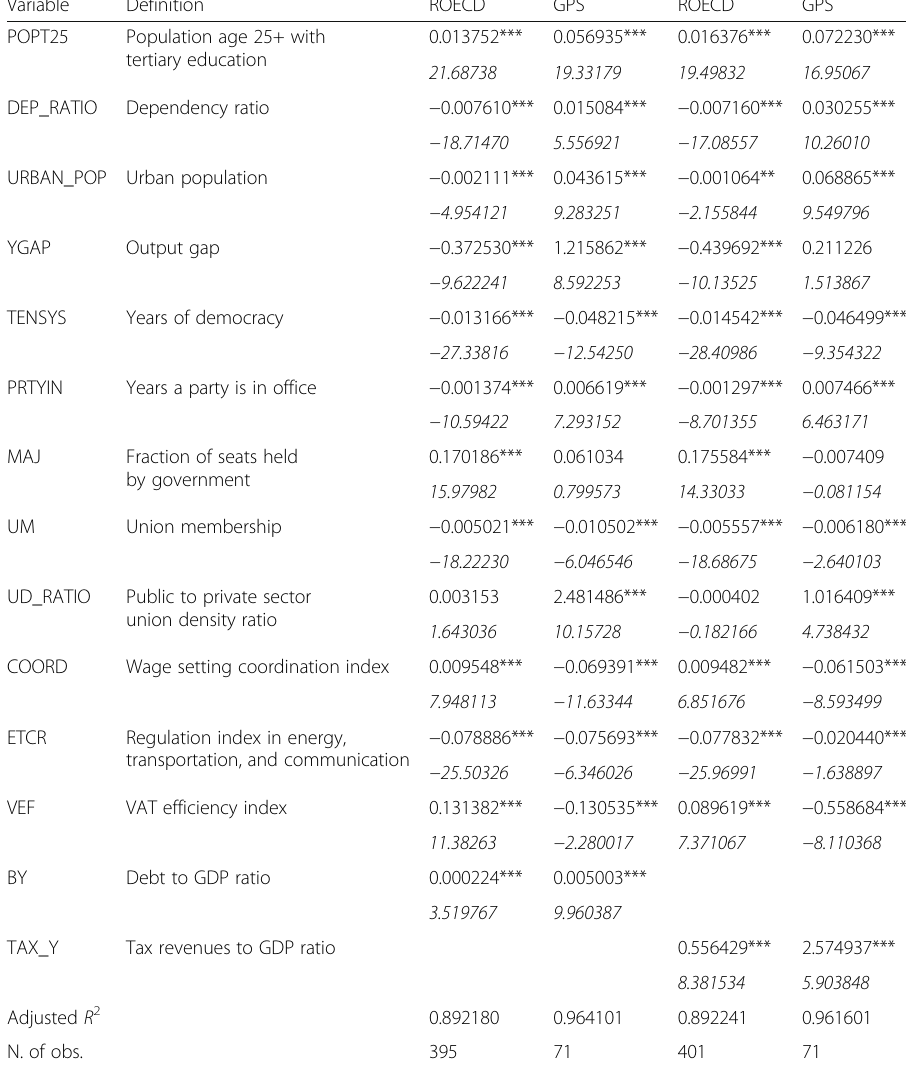
Table 7 A test of the IOS theory — dependent variable: WPR